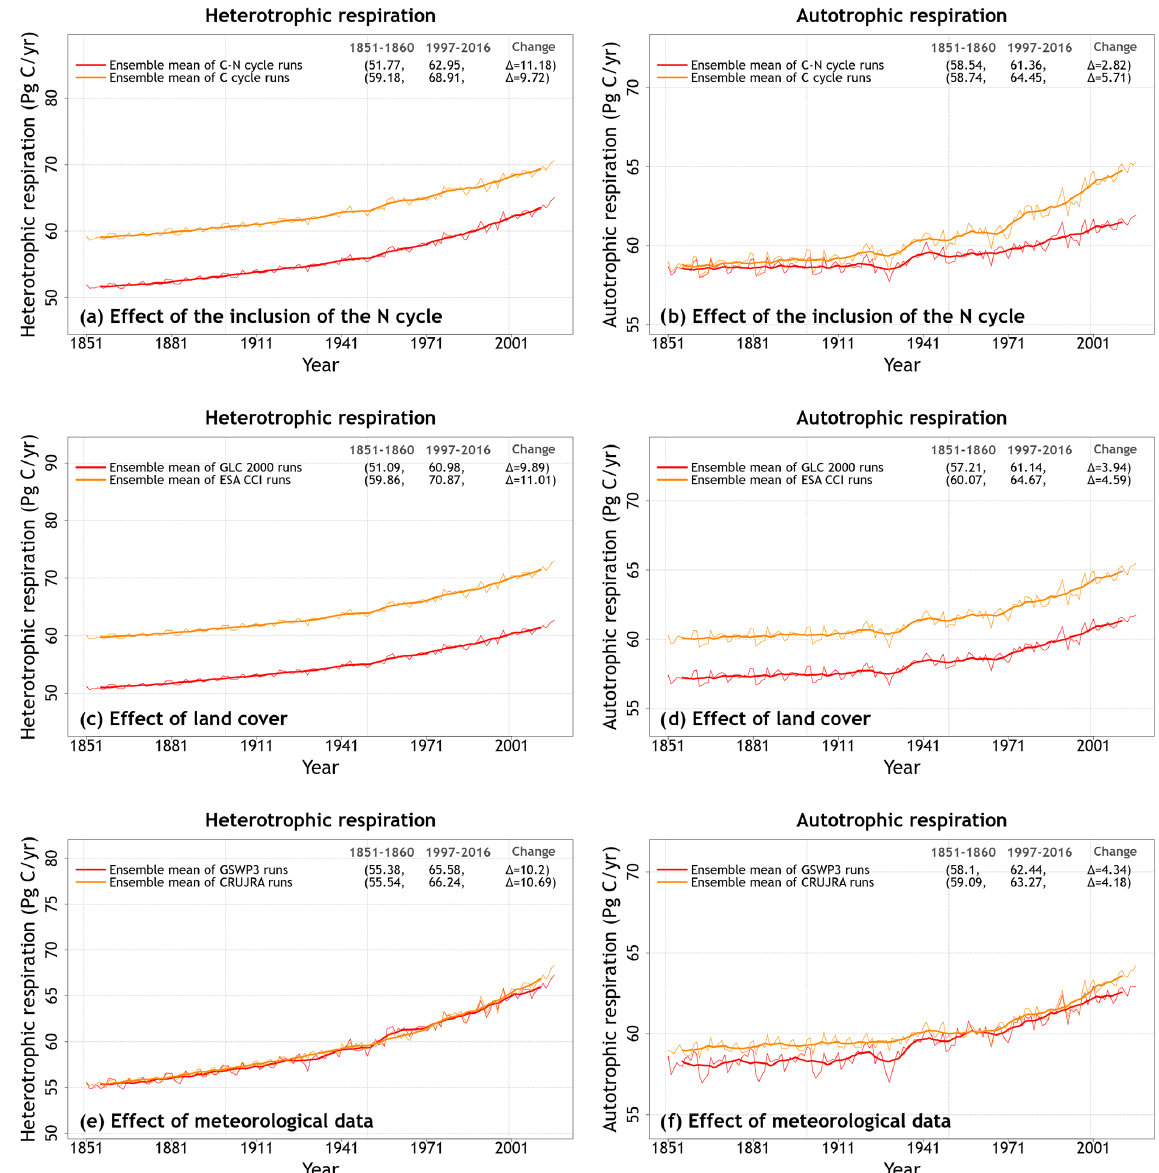
Figure A8. Time series of global heterotrophic and autotrophic respiration (over all land area excluding Greenland and Antarctica), each averaged over the four ensemble members that are driven with and without an interactive N cycle (a, b) , that are driven with the GLC-2000- and ESA-CCI-based land cover (c, d) , and that are driven with the GSWP3 and CRU-JRA meteorological data (e, f) . The thin lines show the individual years, and the thick lines show their 11-year moving average. Model values averaged over the pre-industrial (1851–1860) and present-day (1997–2016) time periods, and their difference, are also